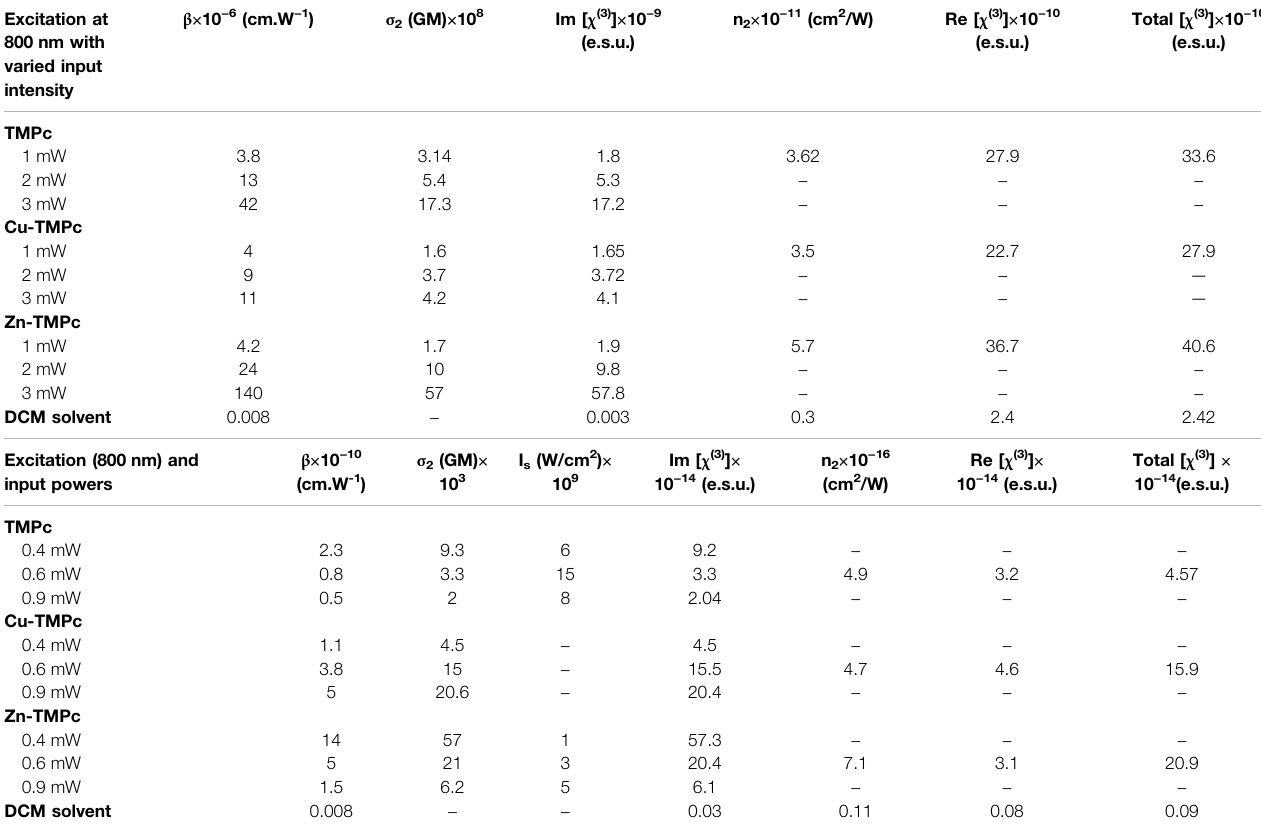
TABLE2| SummaryoftheNLOcoef fi cientsofphthalocyaninesstudiedinthisworkinsolutionform.FemtosecondMHzpulsesat800 nmwereusedfortheseinvestigations. Excitation at 800 nm with varied input